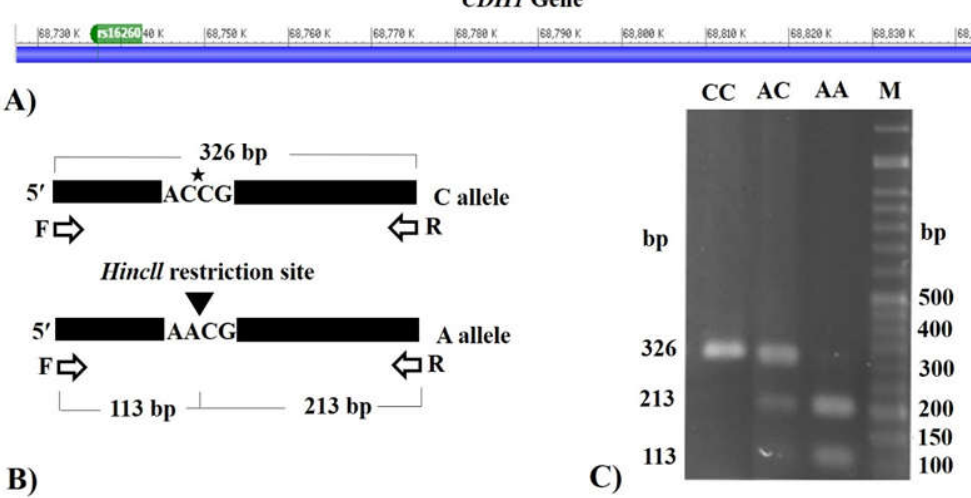
Fig.1. The CDH1 gene map and PCR-RFLP results: Human CDH1 gene map was obtained from NCBI, the rs16260 polymorphism is located on the promoter region of the gene ( A ); Schematic representation of the digestion of the PCR products with HincII restriction enzyme ( B ); The gel electrophoresis of 326 bp fragments containing rs16260 ( C ). Table 2. Genotype and allele frequencies of the CDH1 -160 C>A in cases and healthy individuals